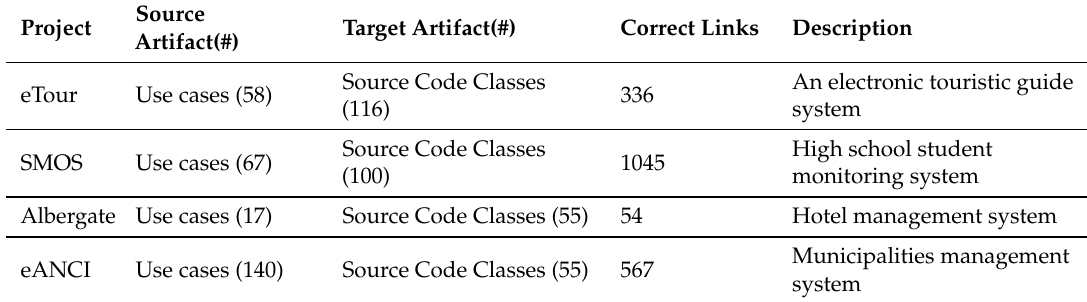
Table 5. Details of the